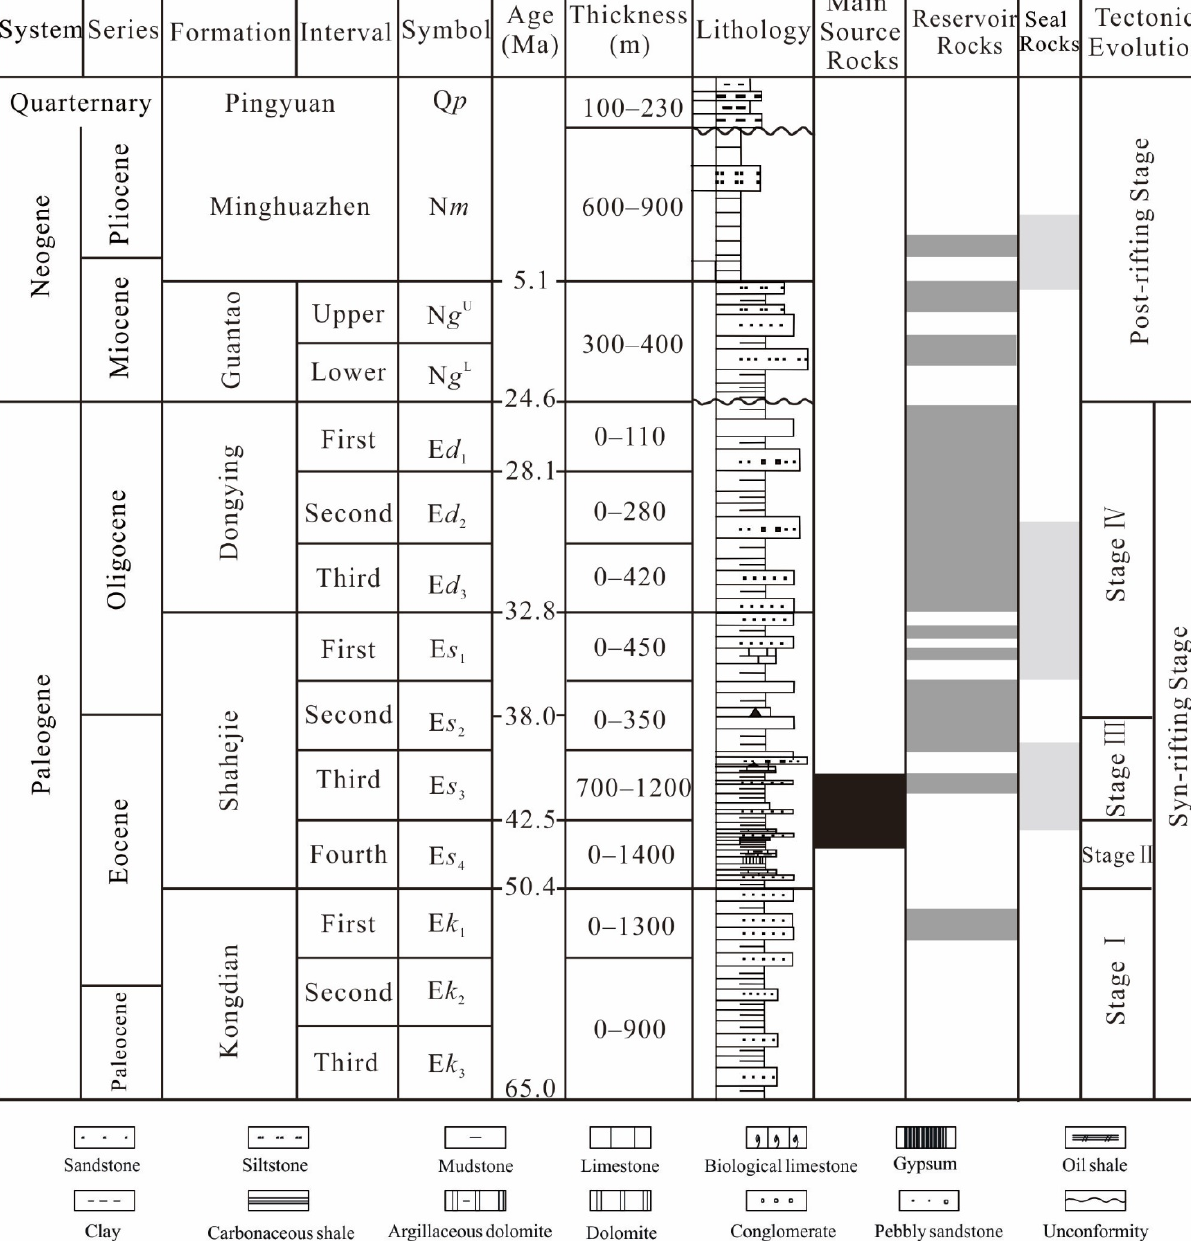
Figure 2. Schematic tertiary stratigraphy of the Dongying Depression in Bohai Bay